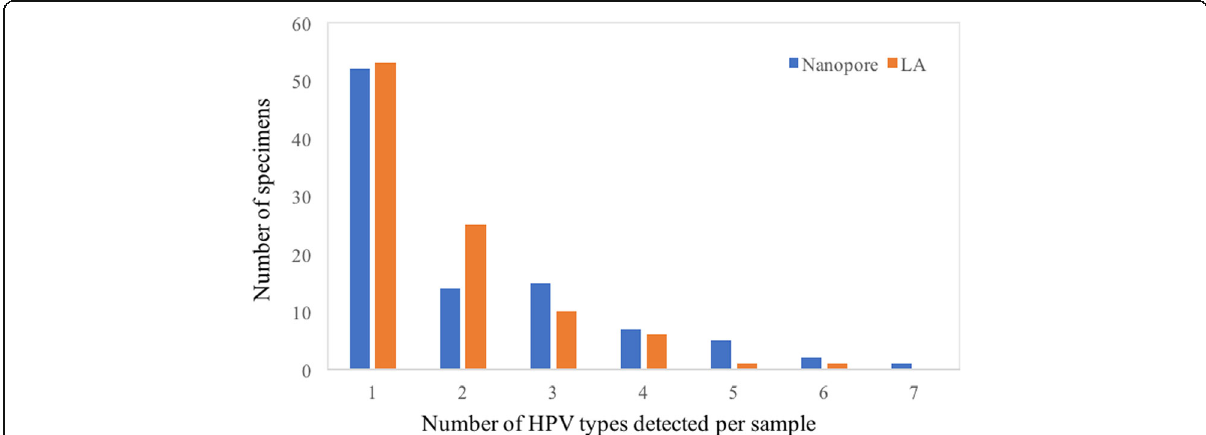
Fig. 1 Number of HPV types detected per sample by Nanopore workflow and LA